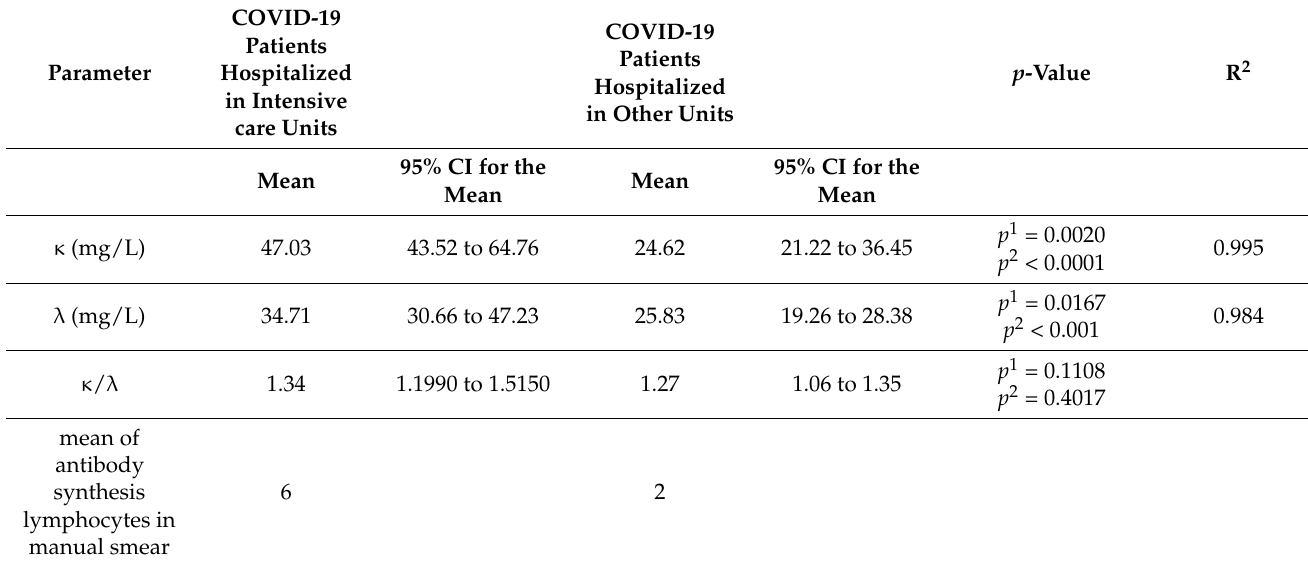
Table 3. Correlation of the light chains with the presence of antibody synthesis lymphocytes in a blood smear ( n = 88).